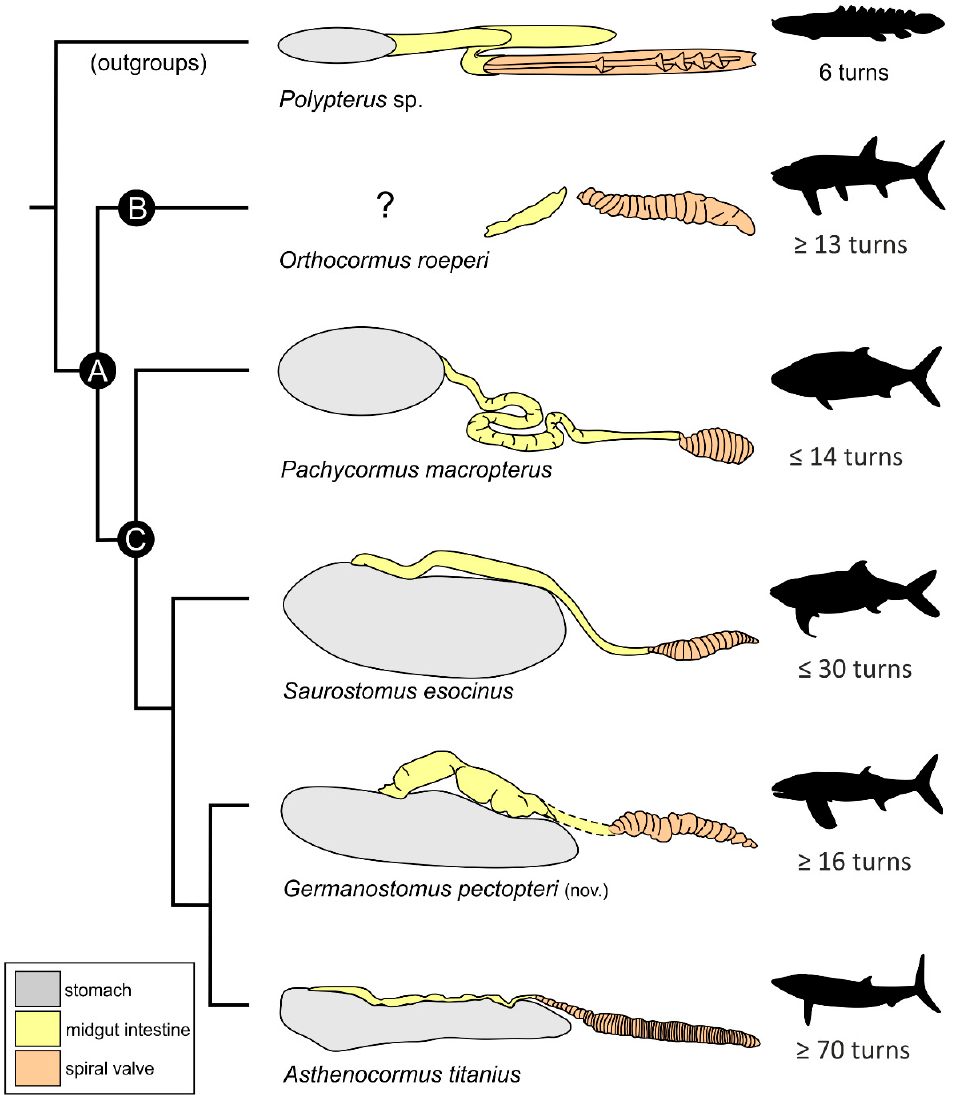
Figure 10. Phylogenetic framework of the gastrointestinal anatomy (GIT) in Pachycormiformes, excluding taxa in which the spiral valve is not preserved. Polypterus sp.: GIT reconstruction and silhouette redrawn and modified from Reference [88]. Pachycormus macropterus , Saurostomus esocinus, and Germanostomus pectopteri gen. et sp. nov.: GIT reconstructions based on first-hand observations of specimens. Orthocormus roeperi: GIT reconstruction drawn from fig.6 of Reference [14]. Asthenocormus titanius from Reference [76], fig 8 with details supplemented from Reference [109]. Gastrointestinal tracts not drawn to scale.